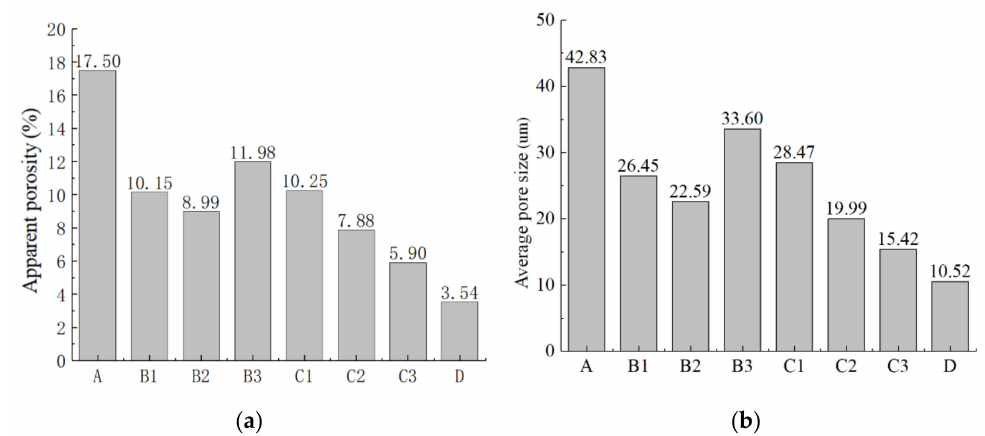
Figure 8. Quantitative analysis of SEM images of sand solidified with various nutrient solution compositions. ( a ) Apparent porosity; ( b ) average pore size.